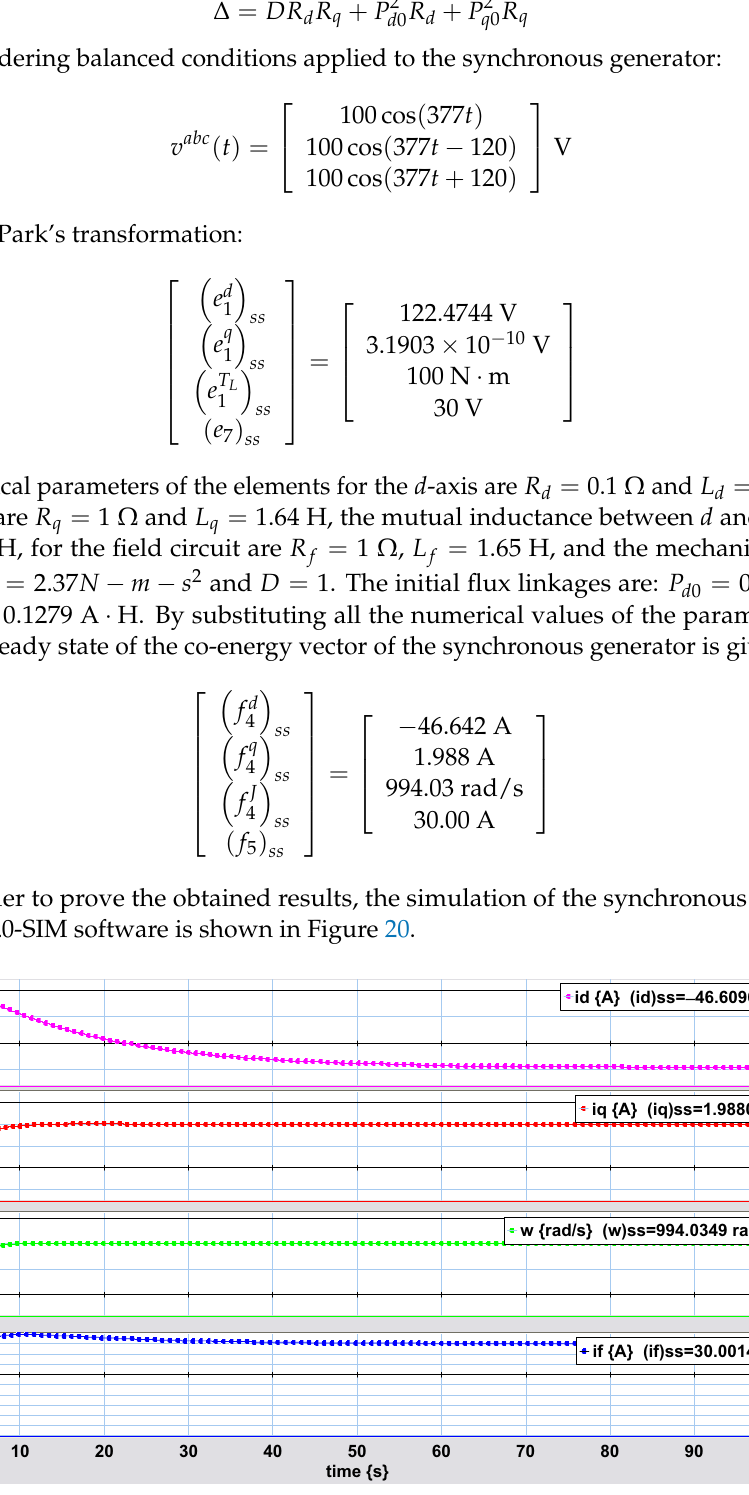
Figure 20. Physical variables’ performance for the synchronous generator: i d , i q , w , and i f . The dynamic behavior based on the MBGI of Figure 18 for the synchronous generator is obtained and shown in Figure 20. The steady state for the variables i d , i q , w , and i f is illustrated, and the results given in ( 96 ) are